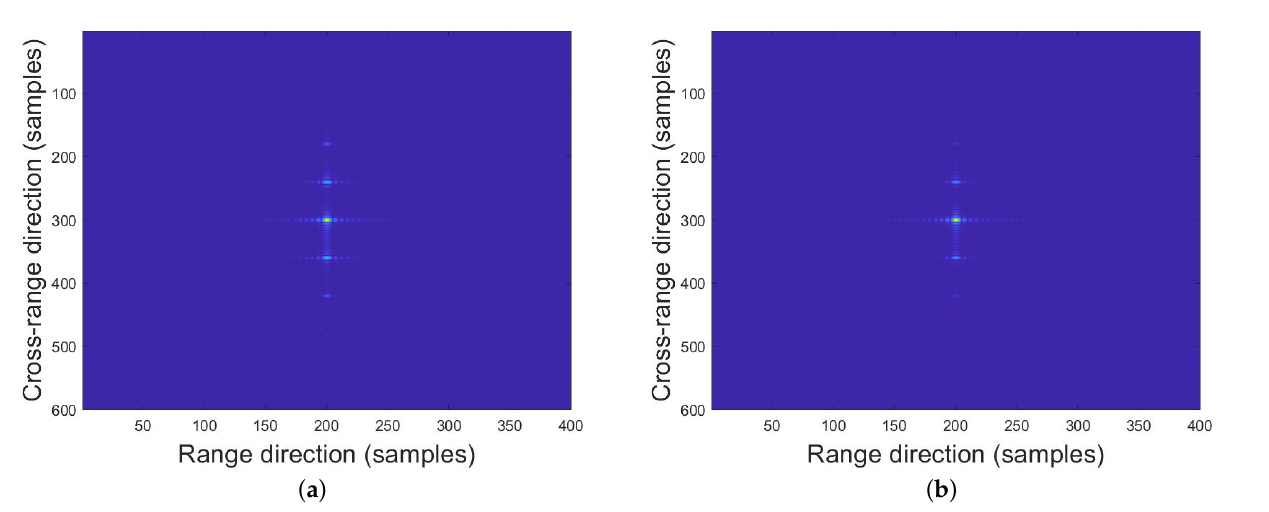
Figure 12. The compensation results of the traditional algorithm [11,23]. ( a ) is the result of target 1. ( b ) is the result of target